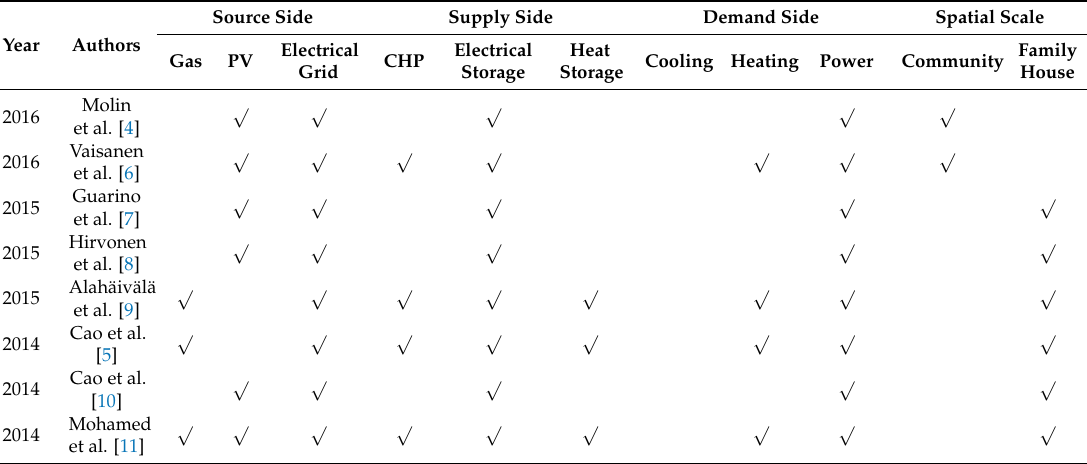
Figure 1. Evolution of distributed energy system topological structure. Table 1. Research status of distributed energy system structure.